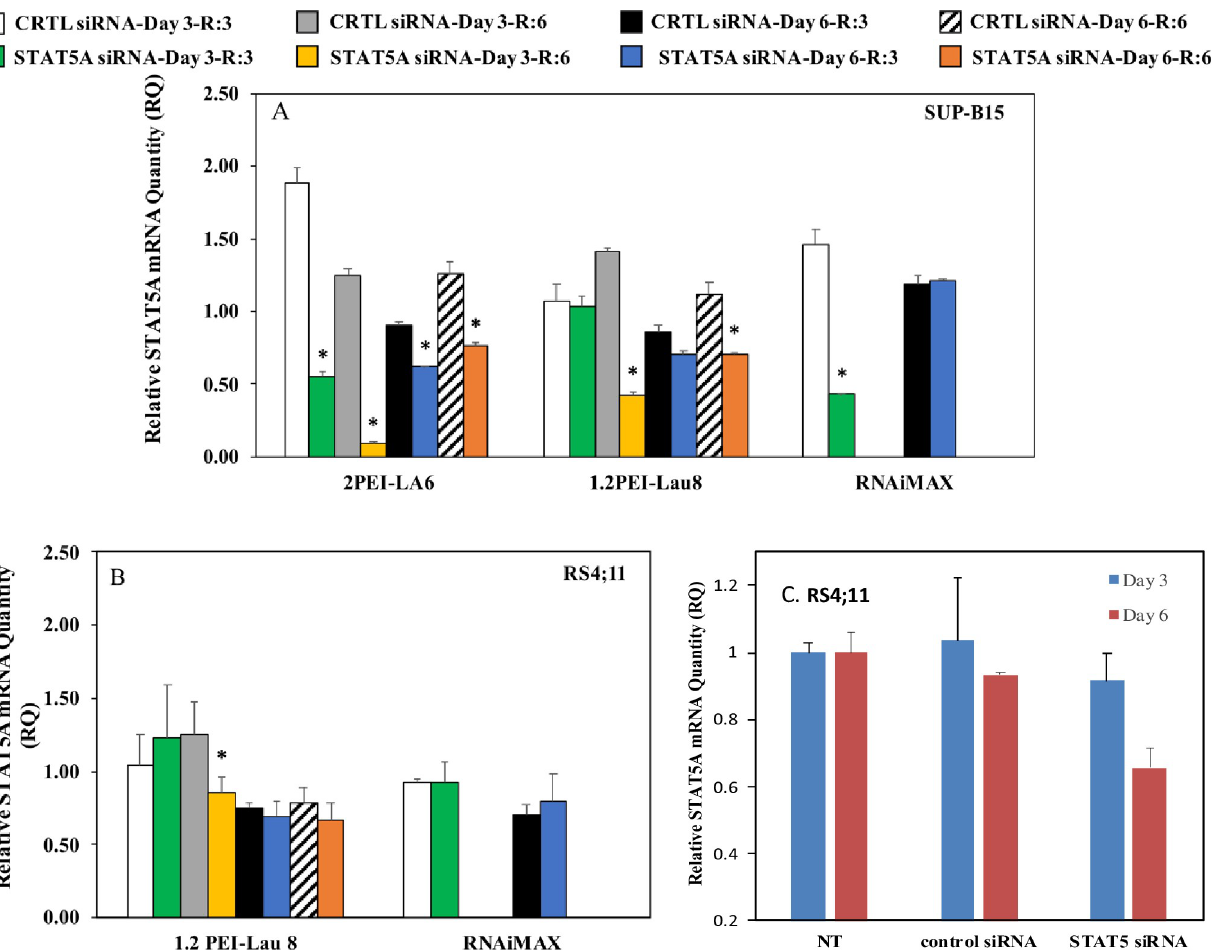
Fig 2. STAT5A mRNA levels after siRNA treatment. The relative STAT5A mRNA levels (relative to β -actin as an internal control) were quantified through qPCR. SUP-B15 (A) and RS4;11 (B and C) cells were treated with 60 nM of STAT5A/CTRL siRNAs for 3 and 6 days and RQ of mRNA are plotted relative to non-treatment group. PEI-Lau8 and PEI-LA6 were used in B and C, respectively, while Lipofectamine RNAiMAX was used as a reference delivery reagent in B. (n = 3) � p � 0.05 vs. Control